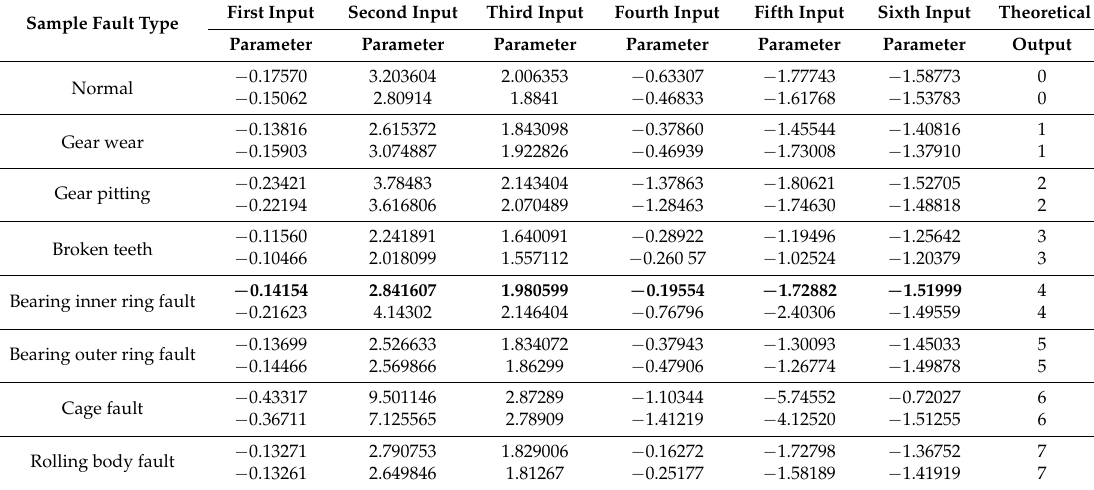
Table 1. Data tables for some of the test samples.